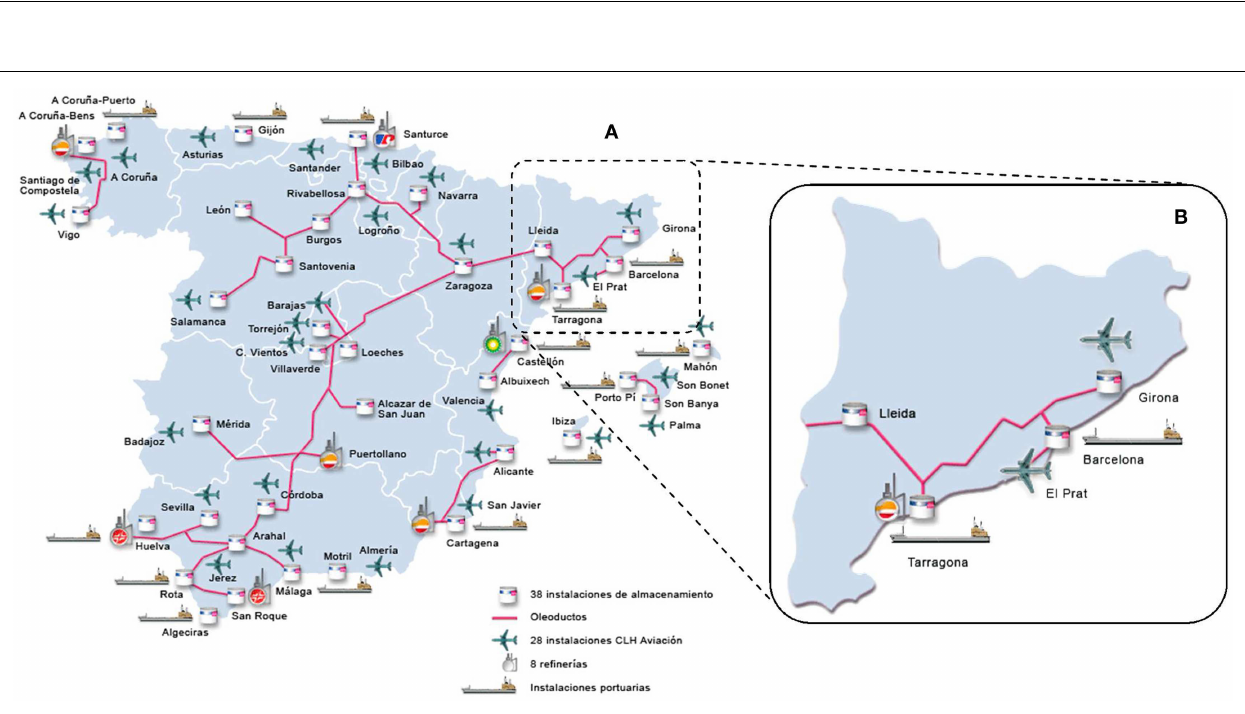
FIGURE 3 | Oil energy network . (A) National Spanish network, with 38 storage facilities, 28 aviation facilities, 8 refineries, and 14 ports. (B) Catalan subsystem, with 2 ports, 4 storage facilities, and 1 refinery (source: http://www.clh.es).